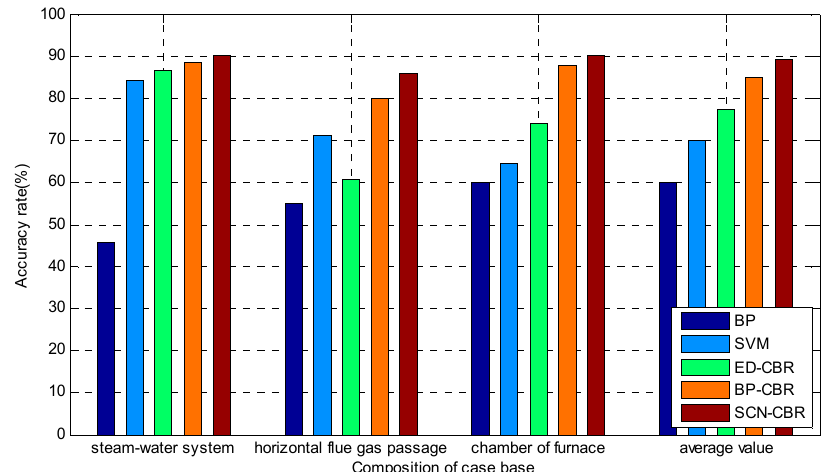
Figure 5. Multi-fault detection accuracy (%).